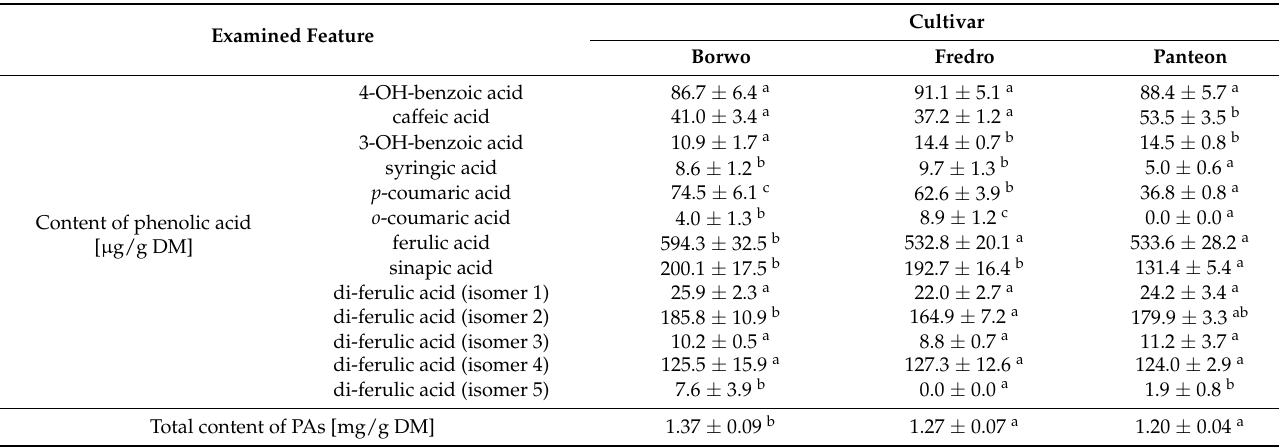
Table 2. Content of phenolic acids in the grain of the examined triticale cultivars. Examined